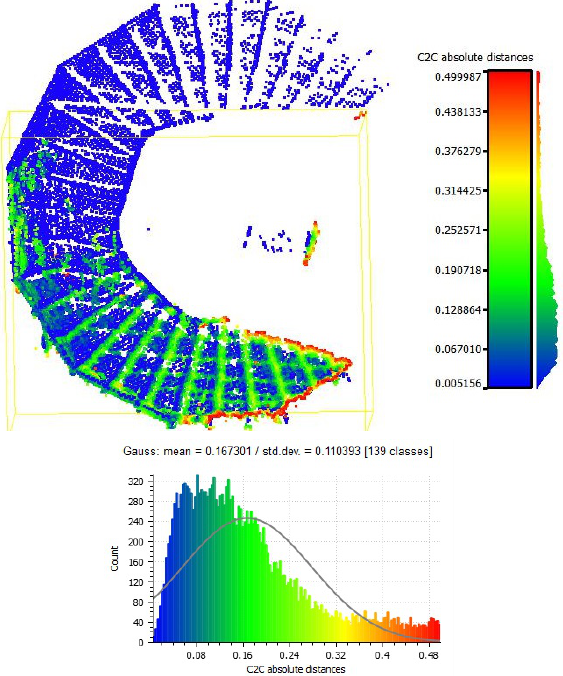
Figure 5: Top; Error values are computed by comparing the distance of the iPhone point cloud points to the closest laser scanning points. Bottom; a histogram of the error values is presented.